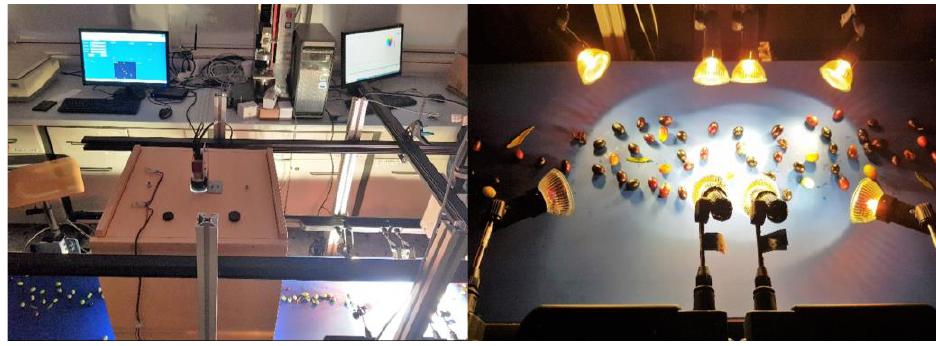
Figure 2. A pilot conveyor belt used to select olives.